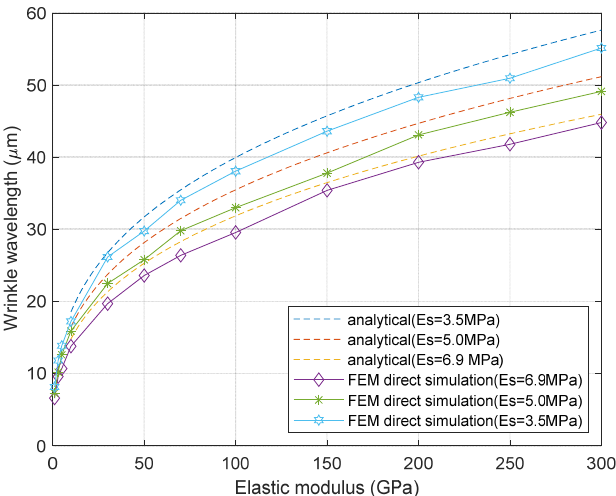
Figure 5. Wrinkling wavelength vs. elastic modulus of thin film as a function of substrate elasticity.